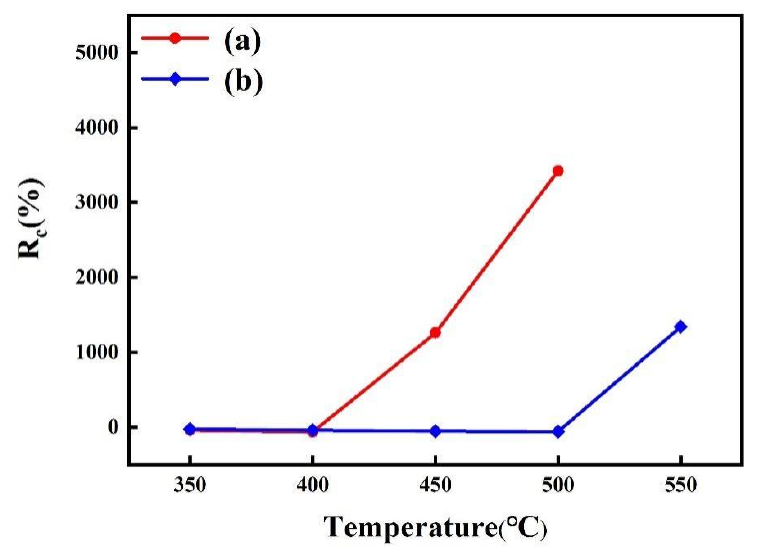
Figure 9. Change in sheet resistance versus annealed temperatures: ( a ) Cu/APTMS/SiO 2 /Si; ( b ) Cu/COOH-APTMS/SiO 2 /Si.